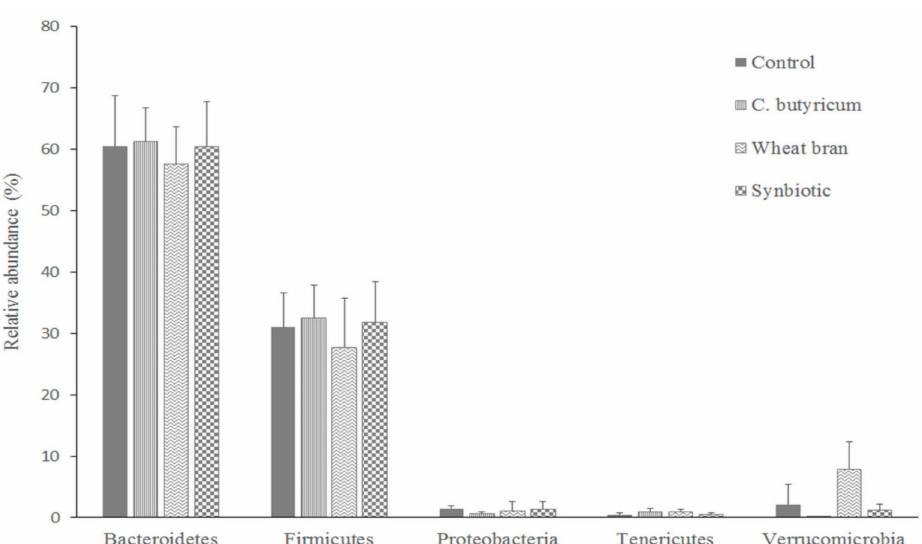
Figure 2. Relative abundances (%) of the most abundant phyla in the cecum of broiler chickens (at day 37 of life) fed control diet, and Clostridium butyricum or diets supplemented by wheat bran respectively or combined the two. Data are presented as the mean values and SEM. Abbreviations: C. butyricum —control group supplemented with 2.5 × 10 9 cfu / kg Clostridium butyricum CBM 588 spores; Wheat bran—wheat bran supplemented group; SYN— Clostridium butyricum and wheat bran supplemented group.